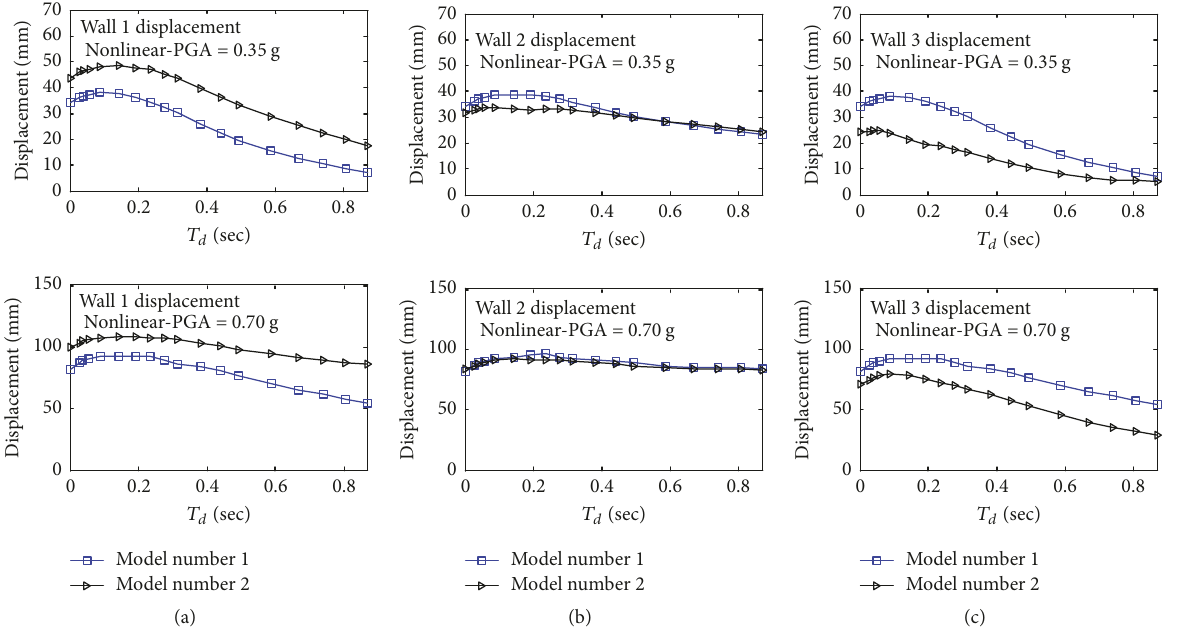
Figure 14: Walls displacements of model 2 in DBE and MCE earthquakes: (a) wall 1 (left side, weak), (b) wall 2 (central), and (c) wall 3 (right side, strong).